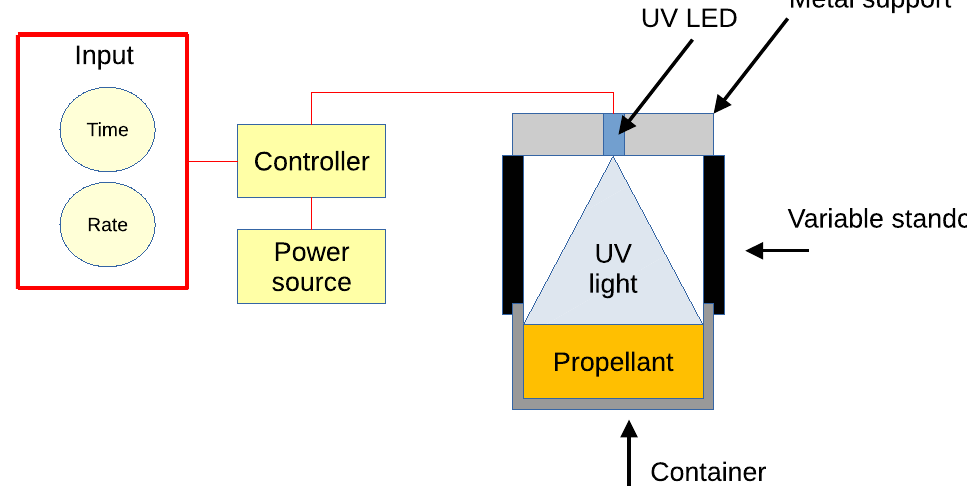
Figure 3. Scheme of the control unit of the UV-curing prototype.